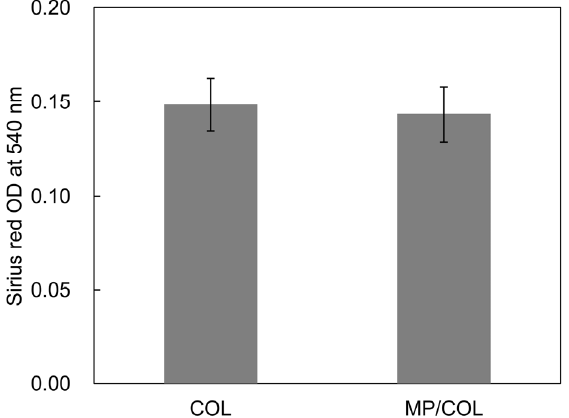
Figure 3. The amount of type I collagen on the